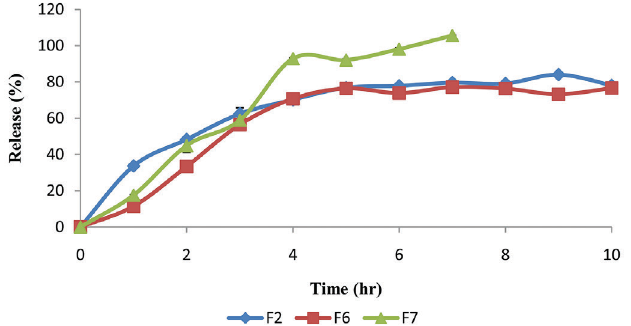
FIGURE 6 - Effect of the drug concentration on the FLB release from chitosan microspheres in PBS: F2 (15%); F6 (30%) and F7